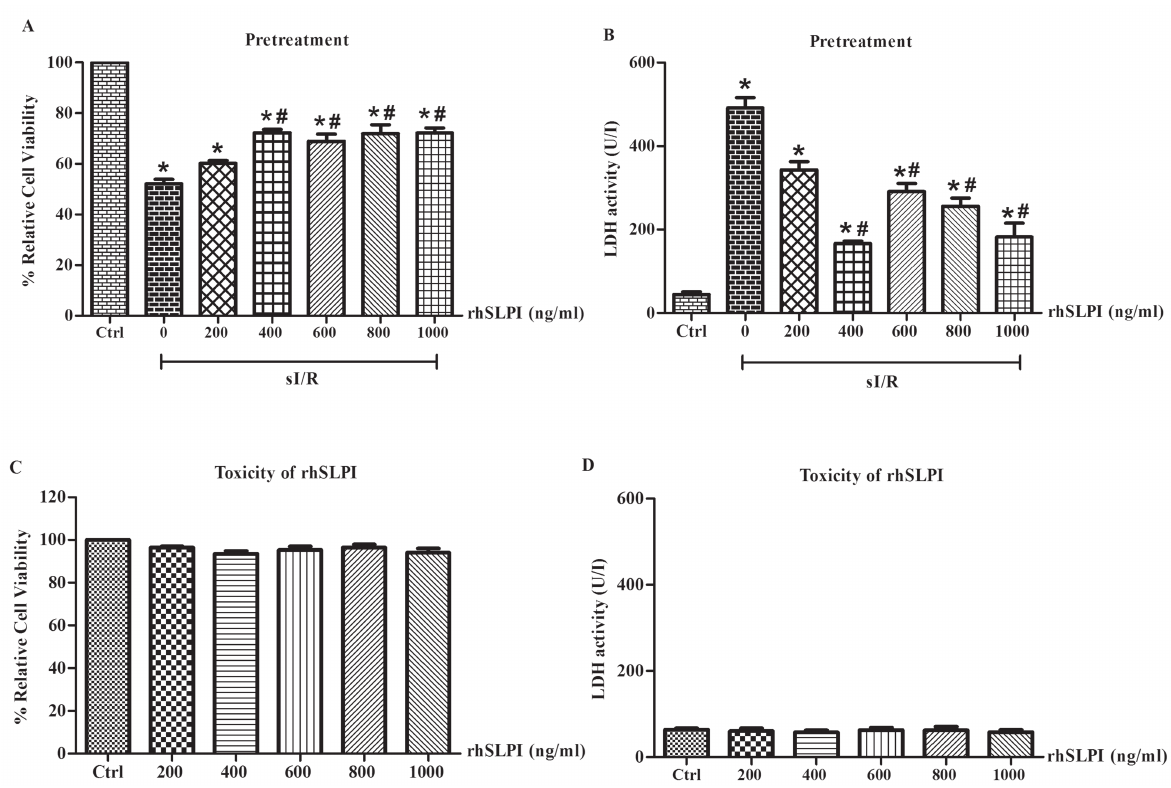
Figure 6: Identification of the maximum rhSLPI concentration required to provide cardio-protection on H9c2 cells subjected to sI/R. H9c2 cells were treated with rhSLPI at 200 ng/ml, 400 ng/ml, 600 ng/ml, 800 ng/ml and 1000 ng/ml for 24 h prior to simulated ischemia followed by 24 h reperfusion. (6A) shows the percentage of cell viability of H9c2 cells treated with various concentrations of rhSLPI; (6B) illustrating the release of LDH activity after the cells were treated with various concentrations of rhSLPI; (6C) The percentage of cell viability and (6D) release of LDH activity after cells incubated with various concentrations of rhSLPI without sI/R are shown. Each bar graph represents means ± S.E.M for each of the six experiments. * p < 0.05 vs control group (ANOVA), # p < 0.05 vs sI